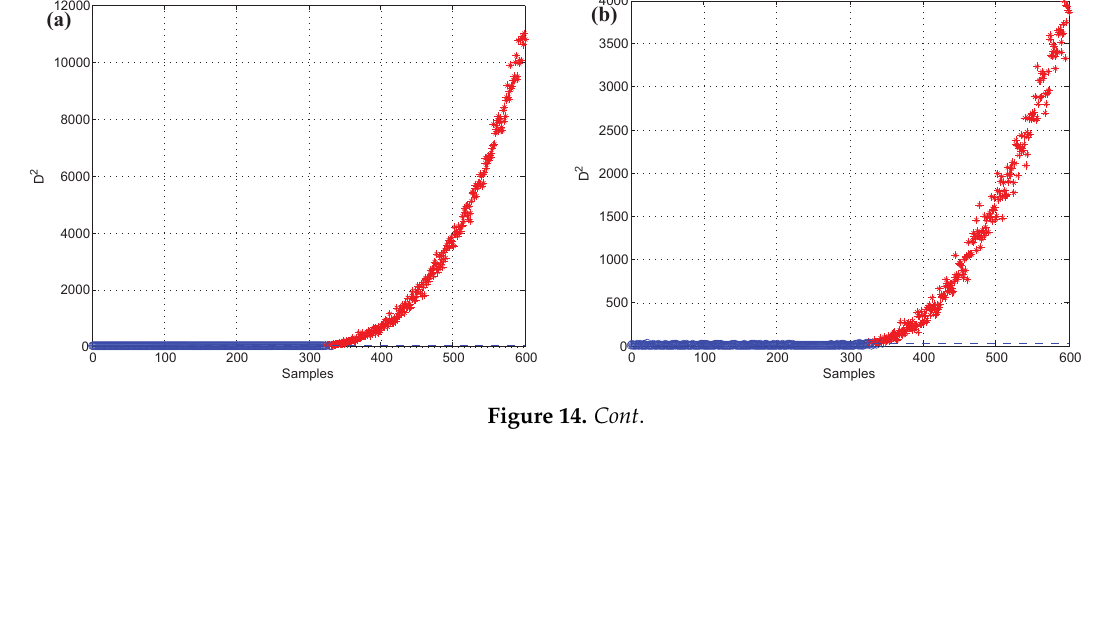
Figure 13. The contribution values of all variables: ( a ) all of the samples, ( b ) the 521th sample.